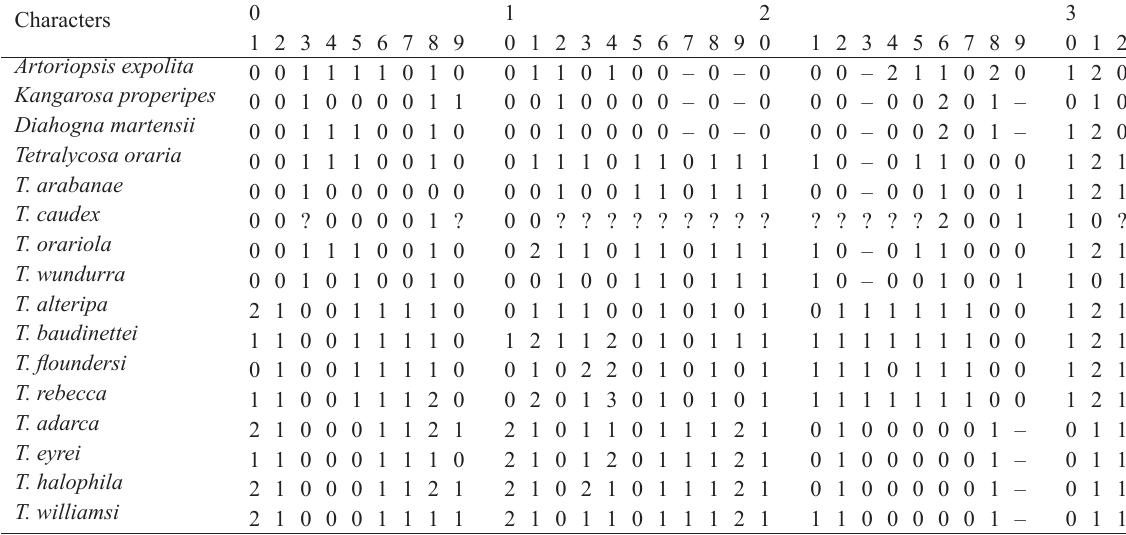
Table 2. Character states for phylogenetic analysis of Tetralycosa Roewer, 1960 and allied Characters